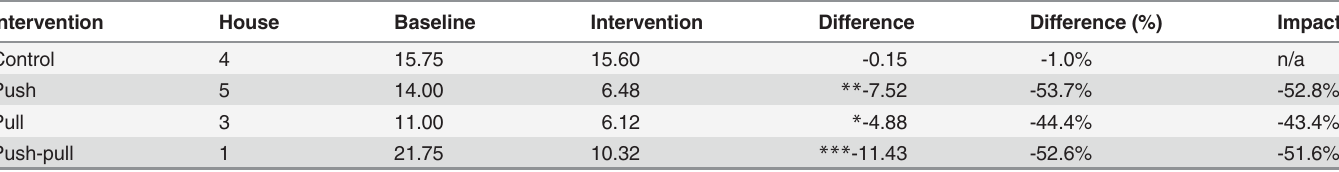
For the baseline data n = 8 (n = 7 for house 3) and n = 25 for the intervention data. Asterisks indicate a signi fi cant difference-in-differences between the control and the